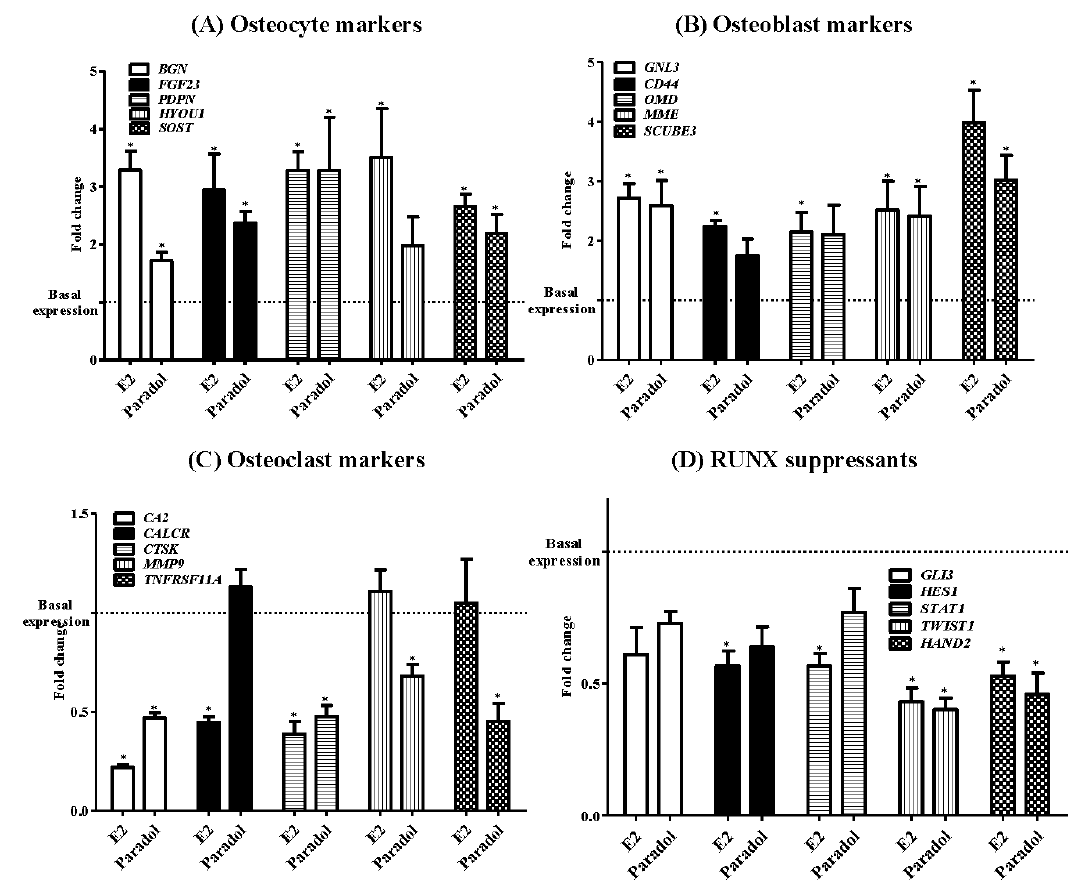
Figure 5. Effect of paradol on mRNA expression of some ossification-related genes in SAOS-2 cell line. Cells were incubated with paradol (1 uM) or E 2 (0.1 uM) for 48 h. Total RNA was extracted and subjected to RT-PCR. Data were normalized to β -actin; fold changes were calculated and expressed as mean ± SD; n = 3. * Significantly different from control untreated cells; p < 0.05.